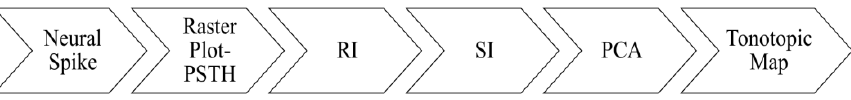
Figure 3. Flow chart on data processing for identification of A1 receptive fields. PSTH, peri-stimulus time histogram; RI, response index; SI, sensitivity index; PCA, principal component analysis.